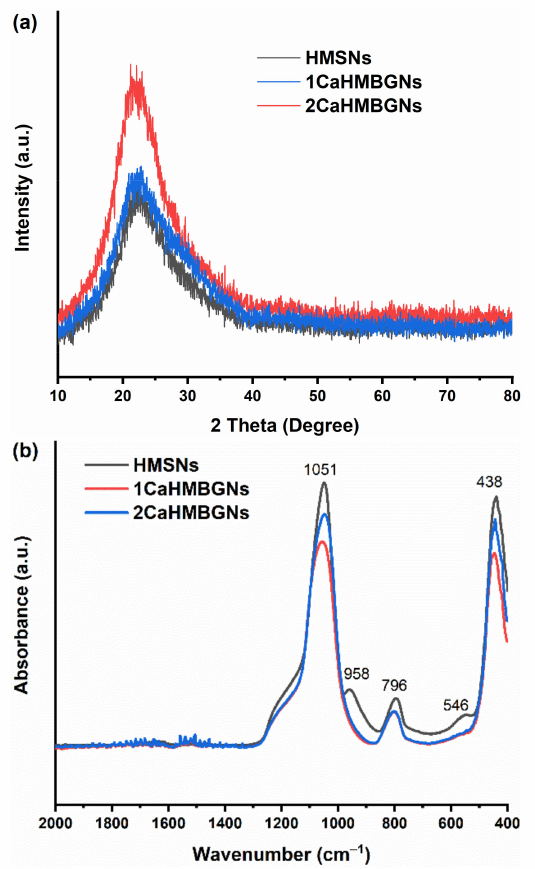
Figure 5. XRD patterns ( a ) and FTIR spectra ( b ) of HMSNs, 1CaHMBGNs, and